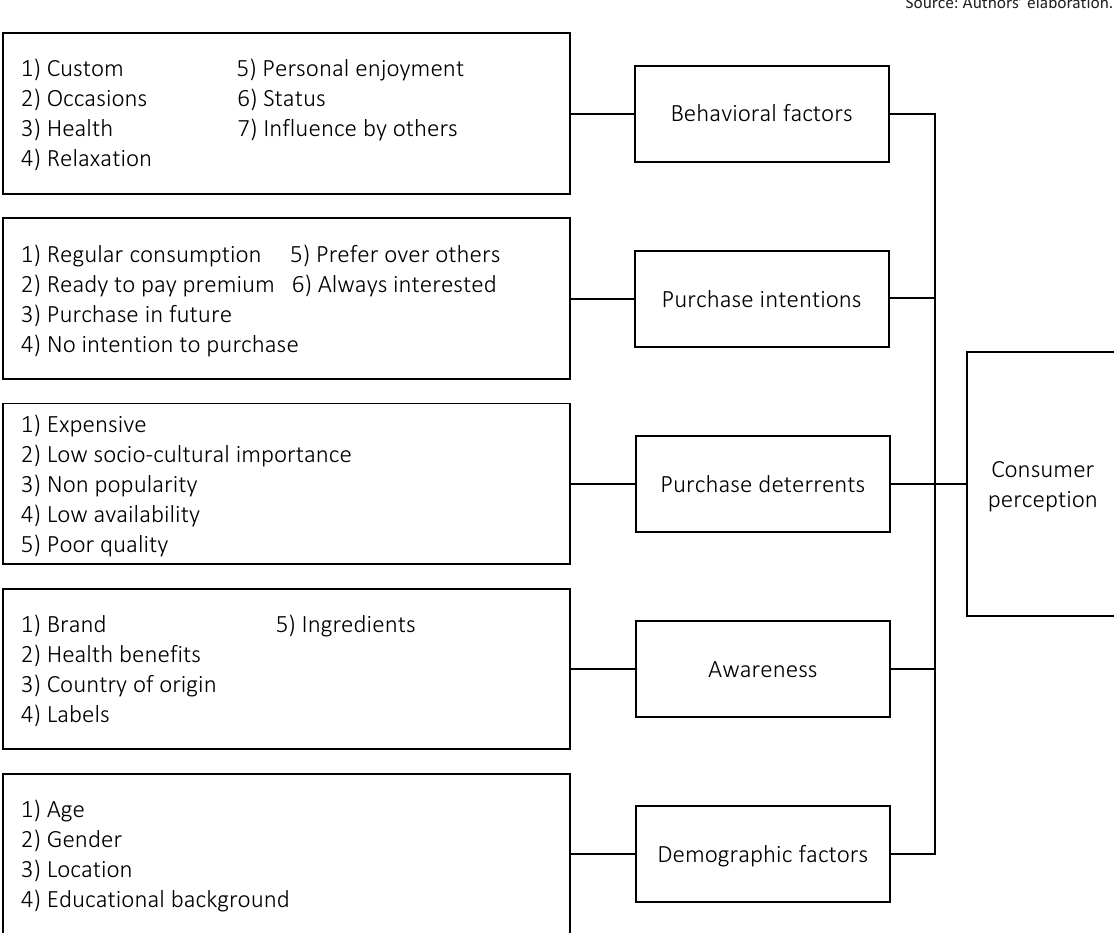
Figure 1. Conceptual framework of different factors and